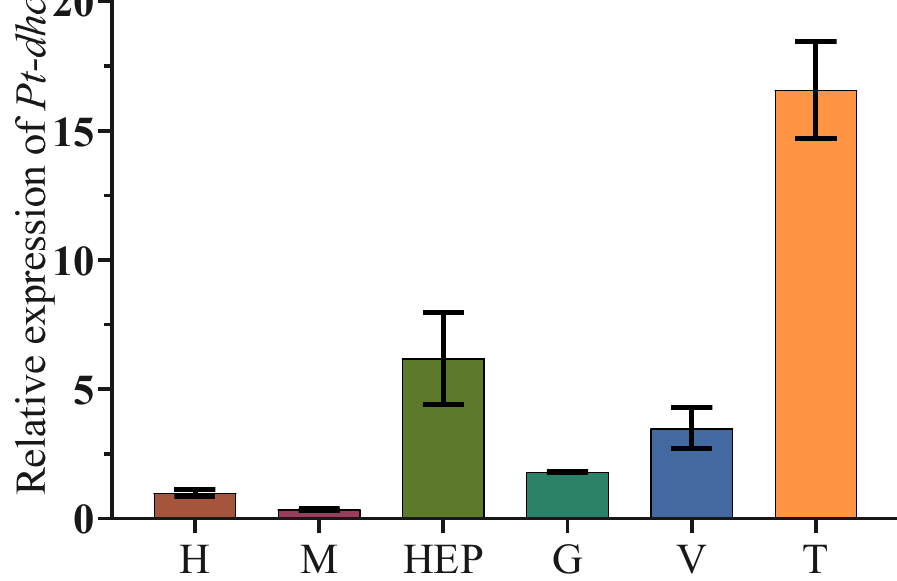
Figure 3. Expression level of Pt-dhc in different tissues. The Pt-dhc is widely expressed in different tissues in P. trituberculatus , with the highest expression in the testis. H: heart; M: muscle; Hep: hepatopancreas; G: gill; V: vas deferens; T: